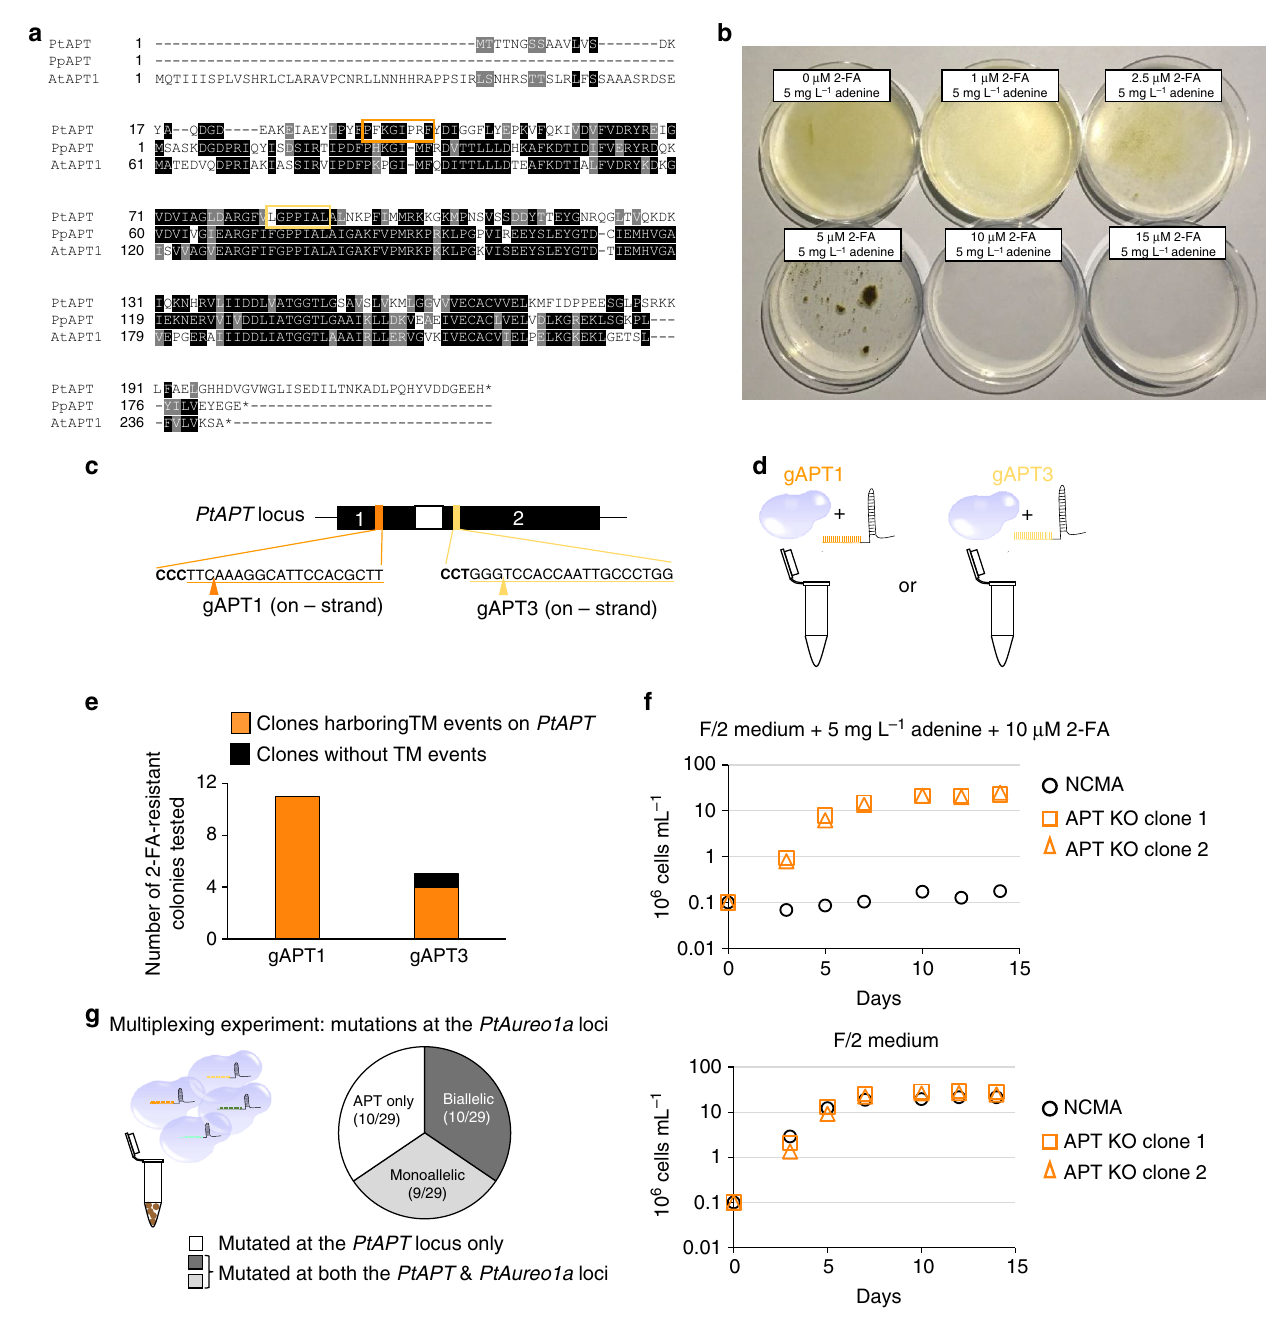
Fig. 4 PtAPT , another endogenous selection marker for DNA-free genome editing. a Alignment of the APT protein sequences from Arabidopsis thaliana (AtAPT1), Physchomitrella patens (PpAPT), and P. tricornutum (PtAPT). Conserved amino acids are highlighted. Orange boxes represent the gRNA targeting sites. b Sensitivity of NCMA (WT) P. tricornutum cells to chronic exposure to various concentrations of 2-FA in the presence of adenine. c Structure of the PtAPT locus. Exons are represented as black boxes, introns as white boxes. Sequences targeted by gAPT1 (dark orange) and gAPT3 (light orange), both of them on the reverse complementary ( − ) strand, are indicated with their Protospacer Adjacent Motives shown in bold font. d RNPs were prepared by complexing either of the corresponding gRNAs to recombinant Cas9. e In vivo evaluation of targeted mutagenesis induced by the Cas9 – gAPT1 or Cas9 – gAPT3 RNP complexes. Phaeodactylum cells bombarded with the corresponding RNP were selected on F/2 medium containing 10 µ M 2-FA plus 5 mg L − 1 adenine. The PtAPT locus of the generated 2-FA-resistant colonies was ampli fi ed by PCR and sequenced. f Representative growth experiment from two independent repeats performed with two bi-allelic APT mutants and the NCMA parental cell grown in F/2 plus 2-FA and F/2 alone. g Frequency of targeted mutagenesis of the PtAureo1a loci in colonies that were simultaneously bombarded with two RNPs against PtAPT (gAPT1 and gAPT3) and two RNPs against PtAureo1a (gAureo1a2 and